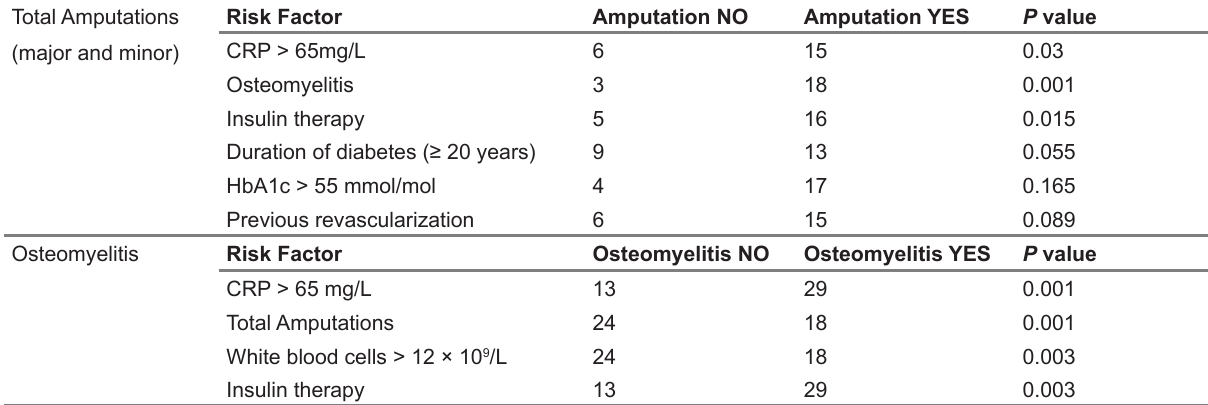
Table 3. Amputation, osteomyelitis and risk factors in 75 patients with DFS enrolled in the